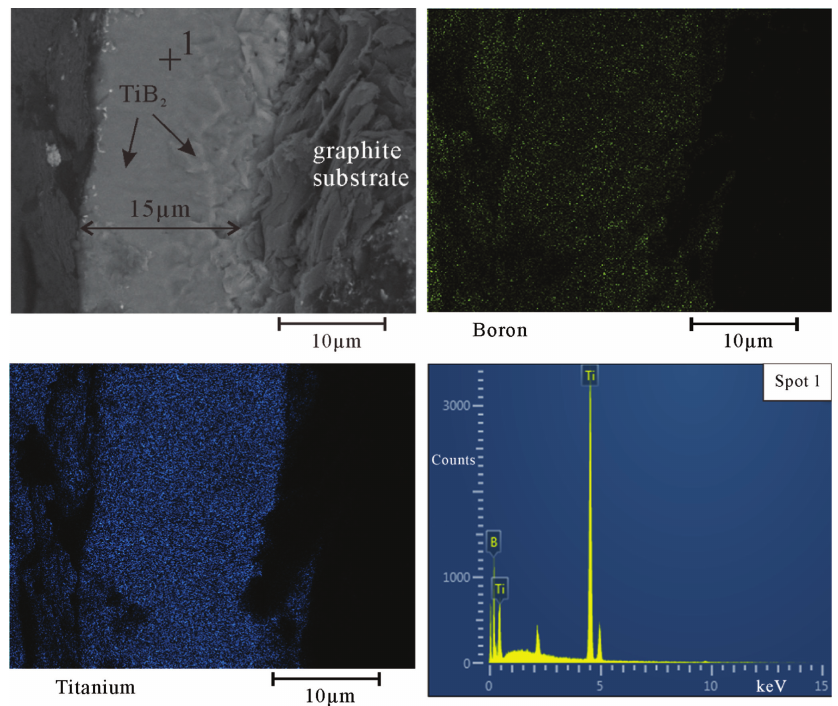
= 1/2, 800 W, 1 /BCl 4 3